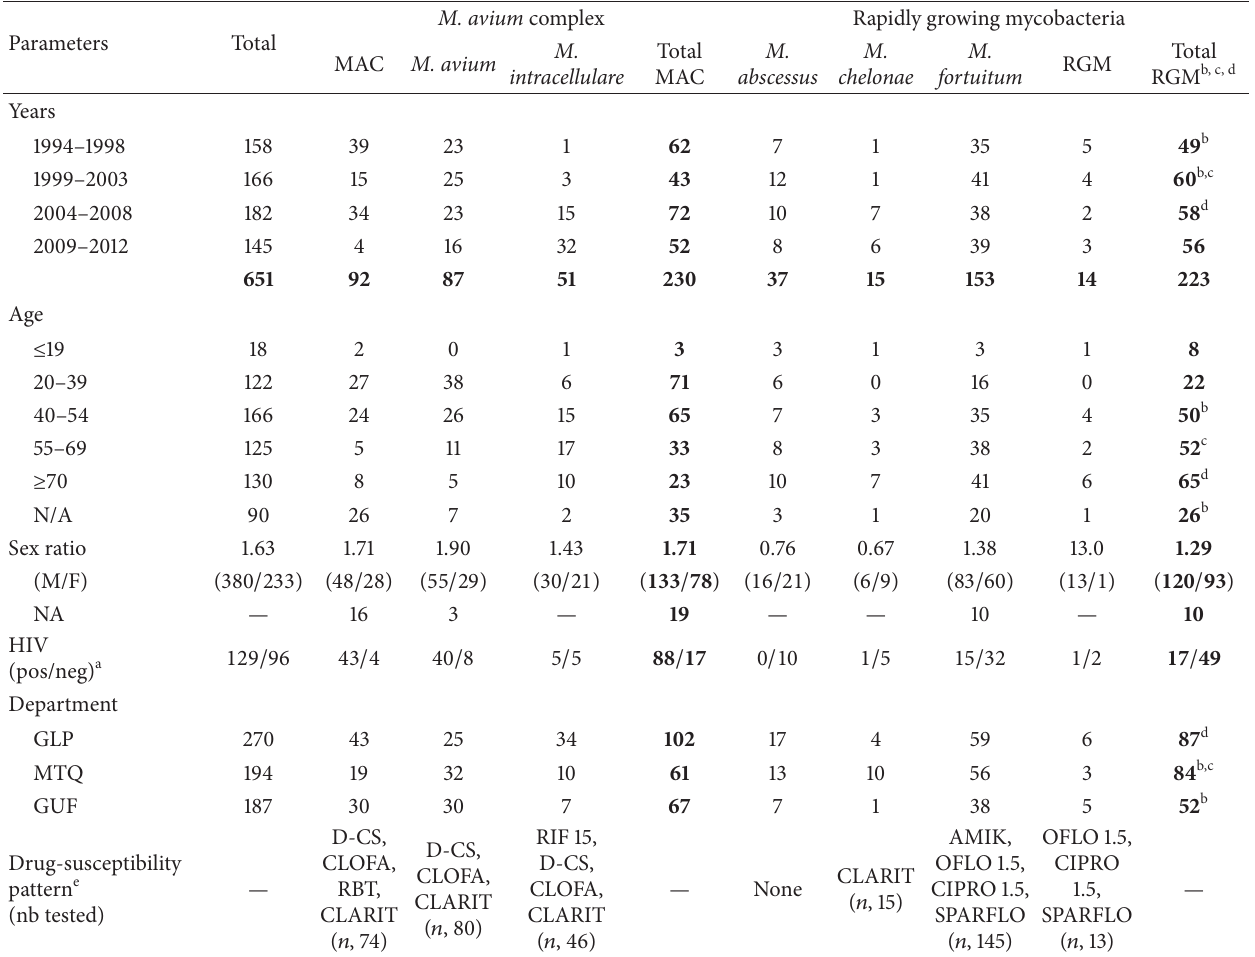
a For patients with known HIV serology; b M. flavescens isolate comprised ; c M. aurum isolate comprised ; d M. mucogenicum isolate comprised. NA: not available; GLP: Guadeloupe; MTQ: Martinique; GUF: French Guiana. e Drug-susceptibility pattern for a given NTM species was defined as ≤ 10% of all isolates displaying in vitro resistance [10]; AMIK: amikacin; CIPRO: ciprofloxacin; CLARIT: clarithromycin; CLOFA: clofazimine; D-CS: D-cycloserine; OFLO: ofloxacin; RBT: rifabutin; RIF: rifampin; SPARFLO: sparfloxacin. Note that drug concentration is mentioned for drugs screened at 2 different